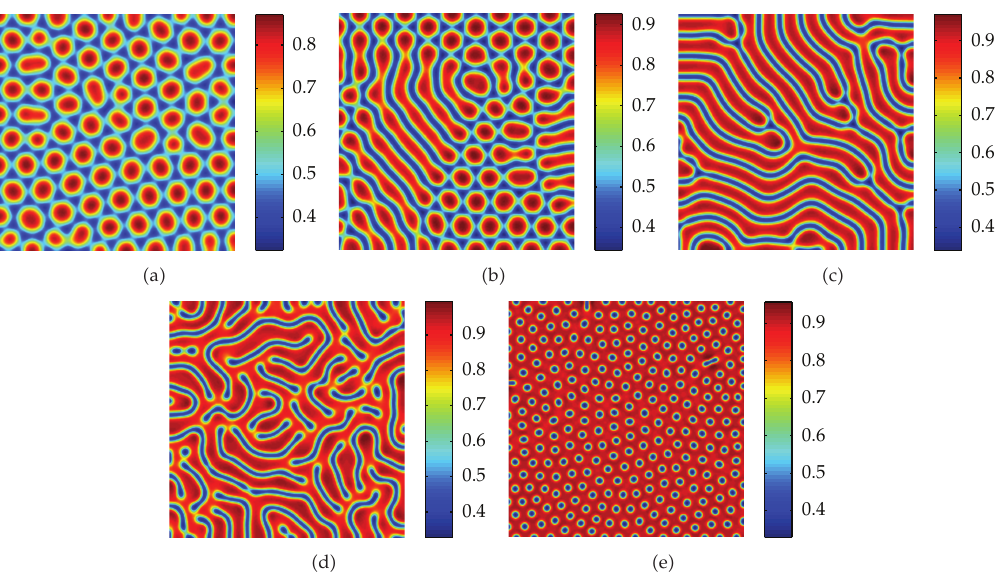
Figure 2: Patterns obtained with model (cid:7) 2.5 (cid:8) for (cid:7) a (cid:8) d 12 (cid:5) 0 . 4, (cid:7) b (cid:8) d 12 (cid:5) 0 . 55, (cid:7) c (cid:8) d 12 (cid:5) 0 . 65, (cid:7) d (cid:8) d 12 (cid:5) 0 . 70, (cid:7) e (cid:8) d (cid:5) 0 . 76 and the other parameters are fixed as (cid:7) 3.1 (cid:8) . Time: t (cid:5) 10000. 12